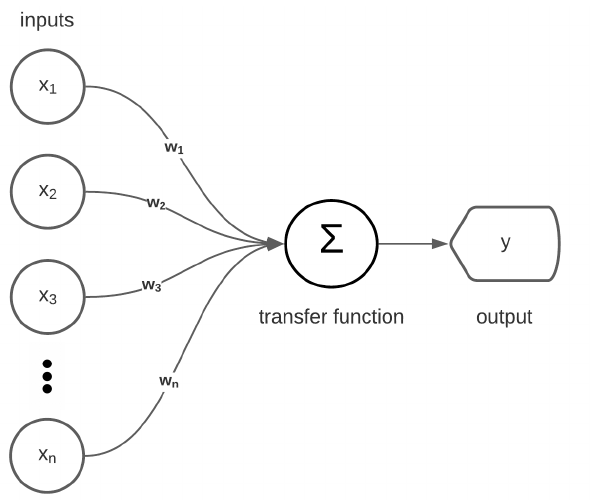
Figure 8. An illustration of a simple ANN. Here, we have multiple inputs (x i ), connected to the neuron with weights (w i ). This output of the neuron is passed to the output (y) via a linear